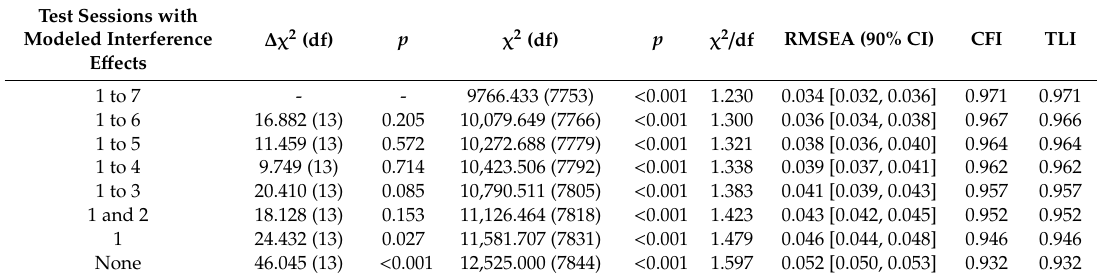
Model fit and comparisons of nested models of interference e ff ects in the interference-reduction